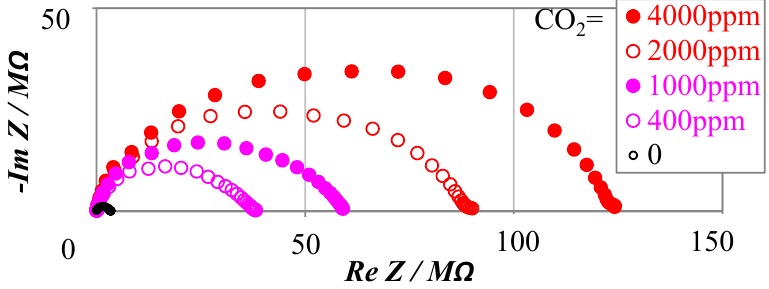
Figure 3. Cole-Cole plots from AC Impedance spectroscopy of hexagonal La 2 O 2 CO 3 . (20 °C 10% rh, Operation temperature = 300 °C).